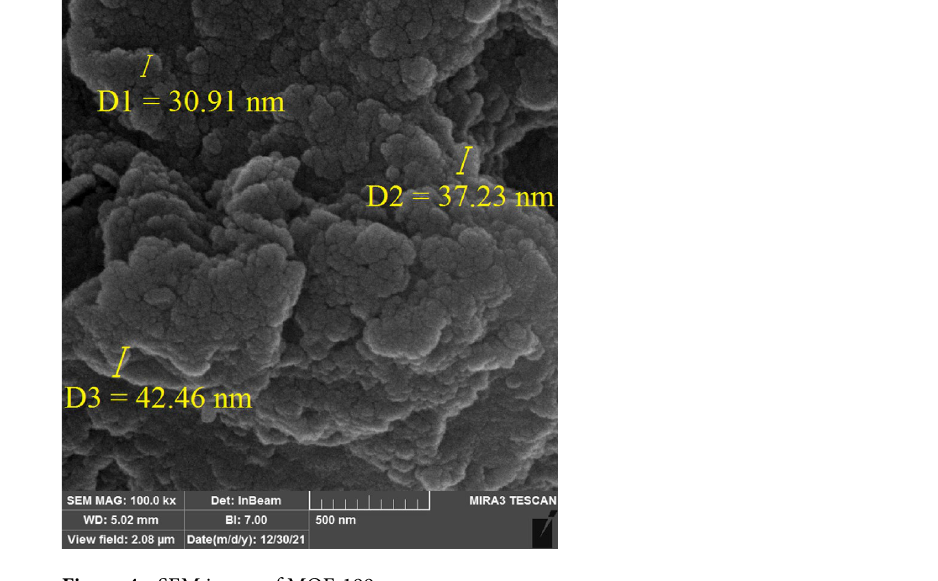
Figure 4. SEM image of MOF-199.